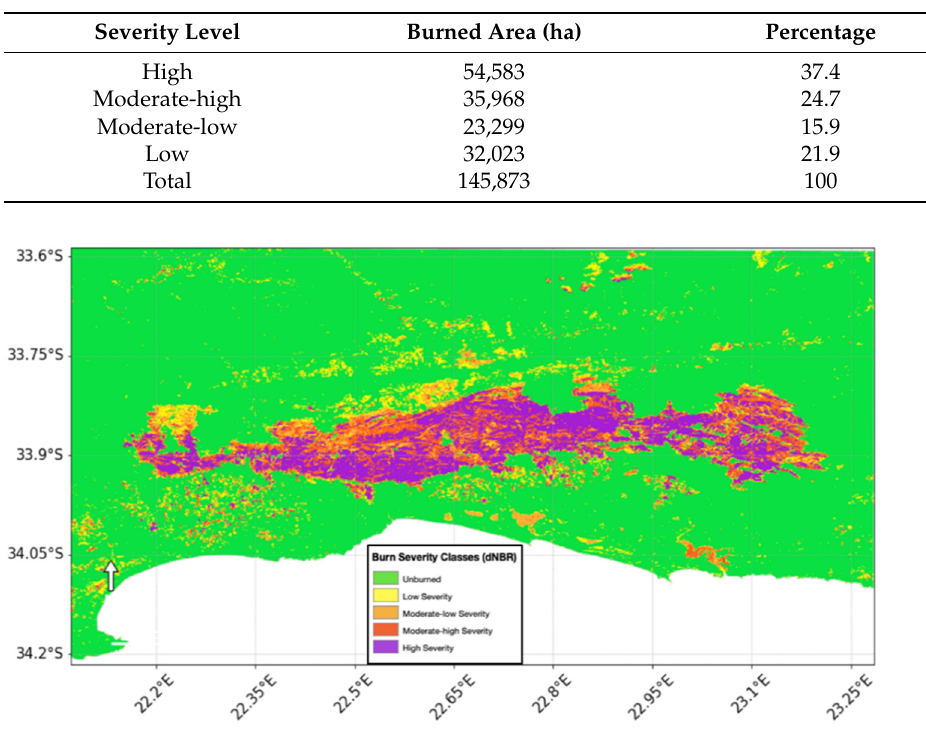
Figure 4. Spatial distribution of burned area by severity class.